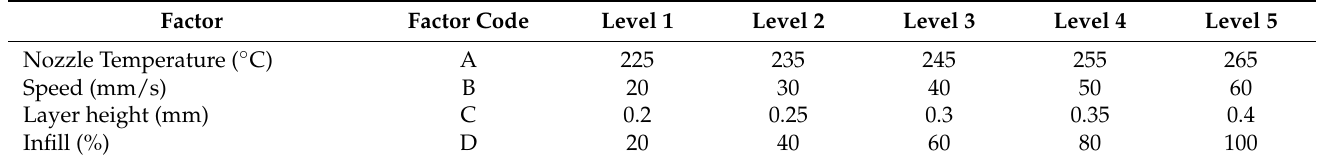
Table 1. Controllable factors and associated levels used in Taguchi experimental design for PETG.